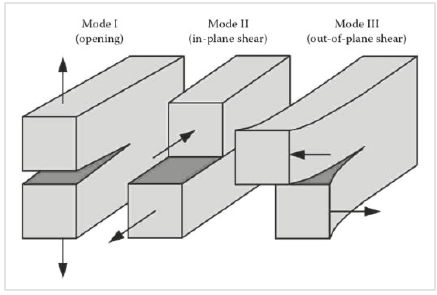
Figure 1. Fracture modes and applied loadings [49].